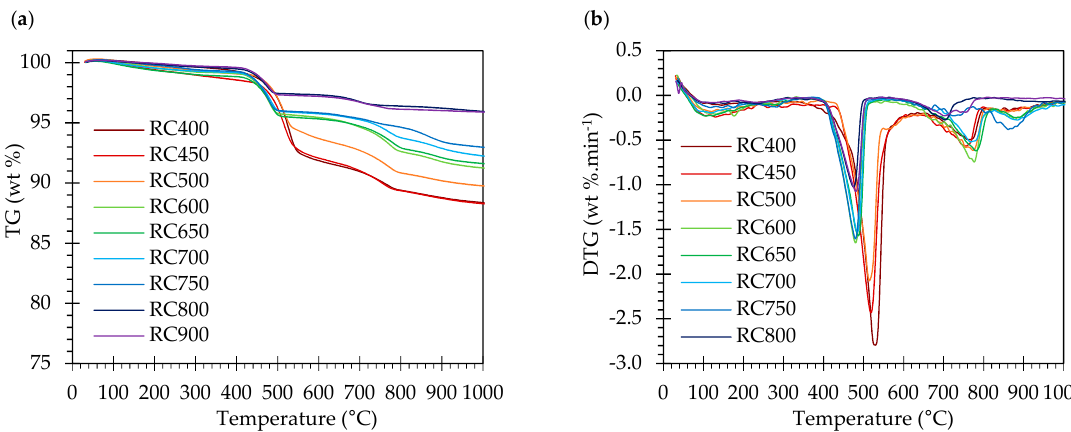
Figure 5. Thermogravimetric analysis: ( a ) TG curves and ( b ) first derivative (DTG) of RC treated at different temperatures.